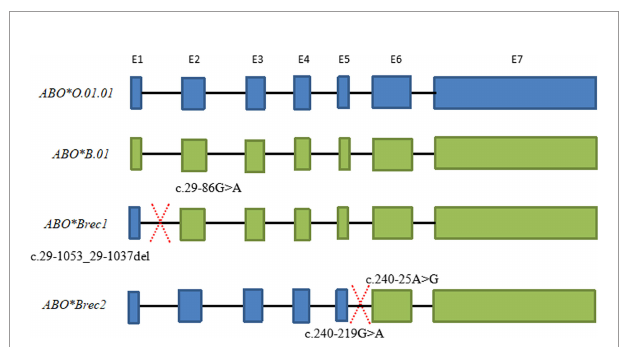
FIGURE 3 | Schematic diagram of ABO allele recombination for two specimens. ABO*Brec1 represents the result of allele recombination for the one homozygous individual ( ABO*B.01 / ABO*B.01). The intron 1 of the ABO*Brec1 allele has the characteristics of the ABO*O.01.01 but sequence from exon 2 to exon 7 has characteristics of the ABO*B.01 , and the recombination event maybe happen from c.29-86G>A and c.29-1053_29-1037del. ABO*Brec2 represents the result of allele recombination for the specimen with the ID of 19047. According to the sequence of the ABO*Brec2 allele, the sequence from intron 1 to intron 5 has the characteristics of the ABO*O.01.01 but the sequences from exon 6 to exon 7 have characteristics for ABO*B.01 . The recombination event maybe happens from c.240-219G>A to